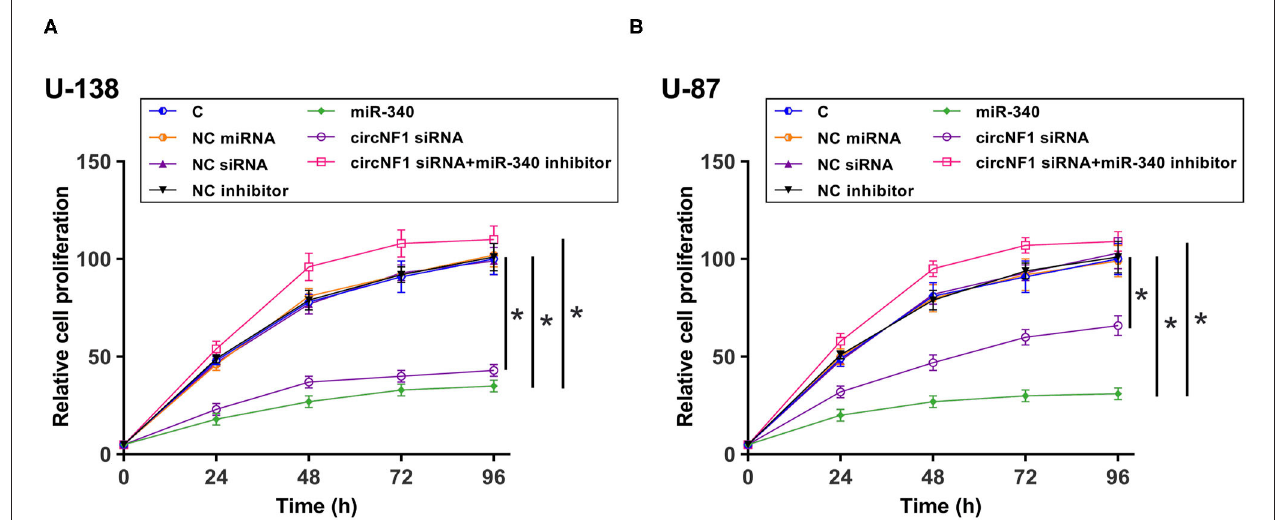
FIGURE 5 | circNF1 siRNA suppressed the proliferation of GBM cell through miR-340. Cell Counting Kit 8 assay was performed to analyze the role of circNF1 and miR-340 in regulating the proliferation of U-138 (A) and U-87 cells (B) . Data from cell transfection experiments were expressed as mean ± SD values of three biological replicates, and data comparisons were performed by ANOVA Tukey’s test. * p <